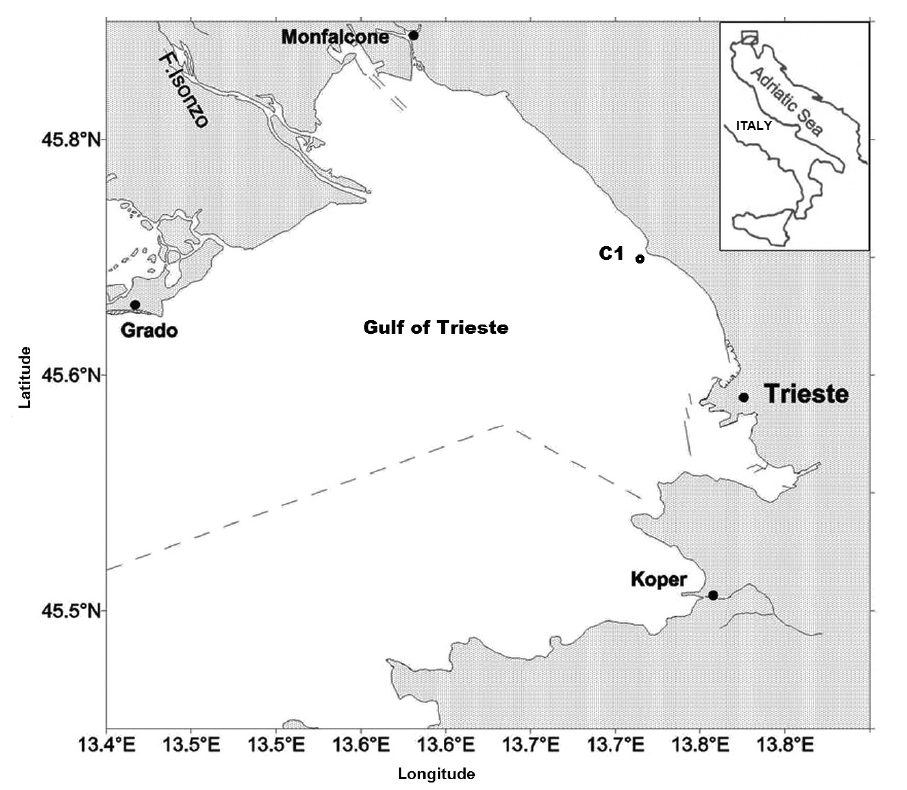
Figure 1. Map of the Gulf of Trieste showing the location of the LTER sampling station